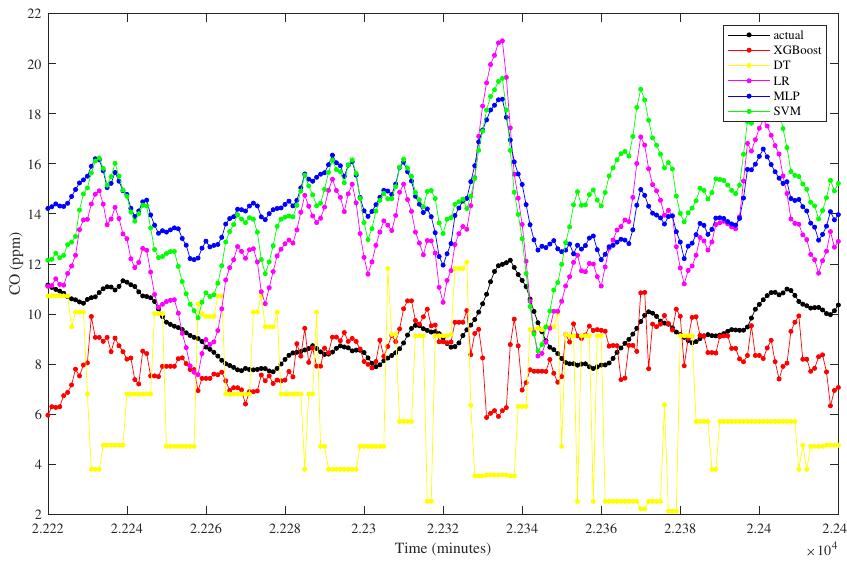
Figure 15. CO prediction comparison.